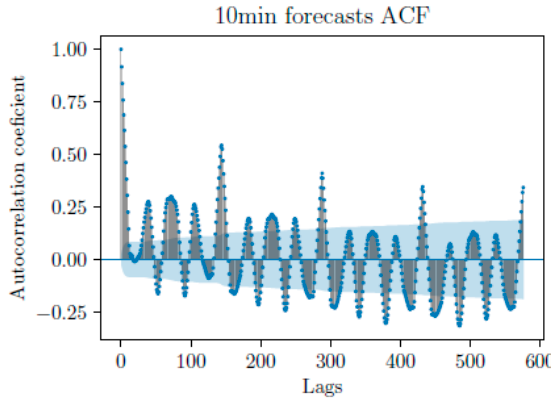
Figure 16. Twelve-hours-ahead error autocorrelation.